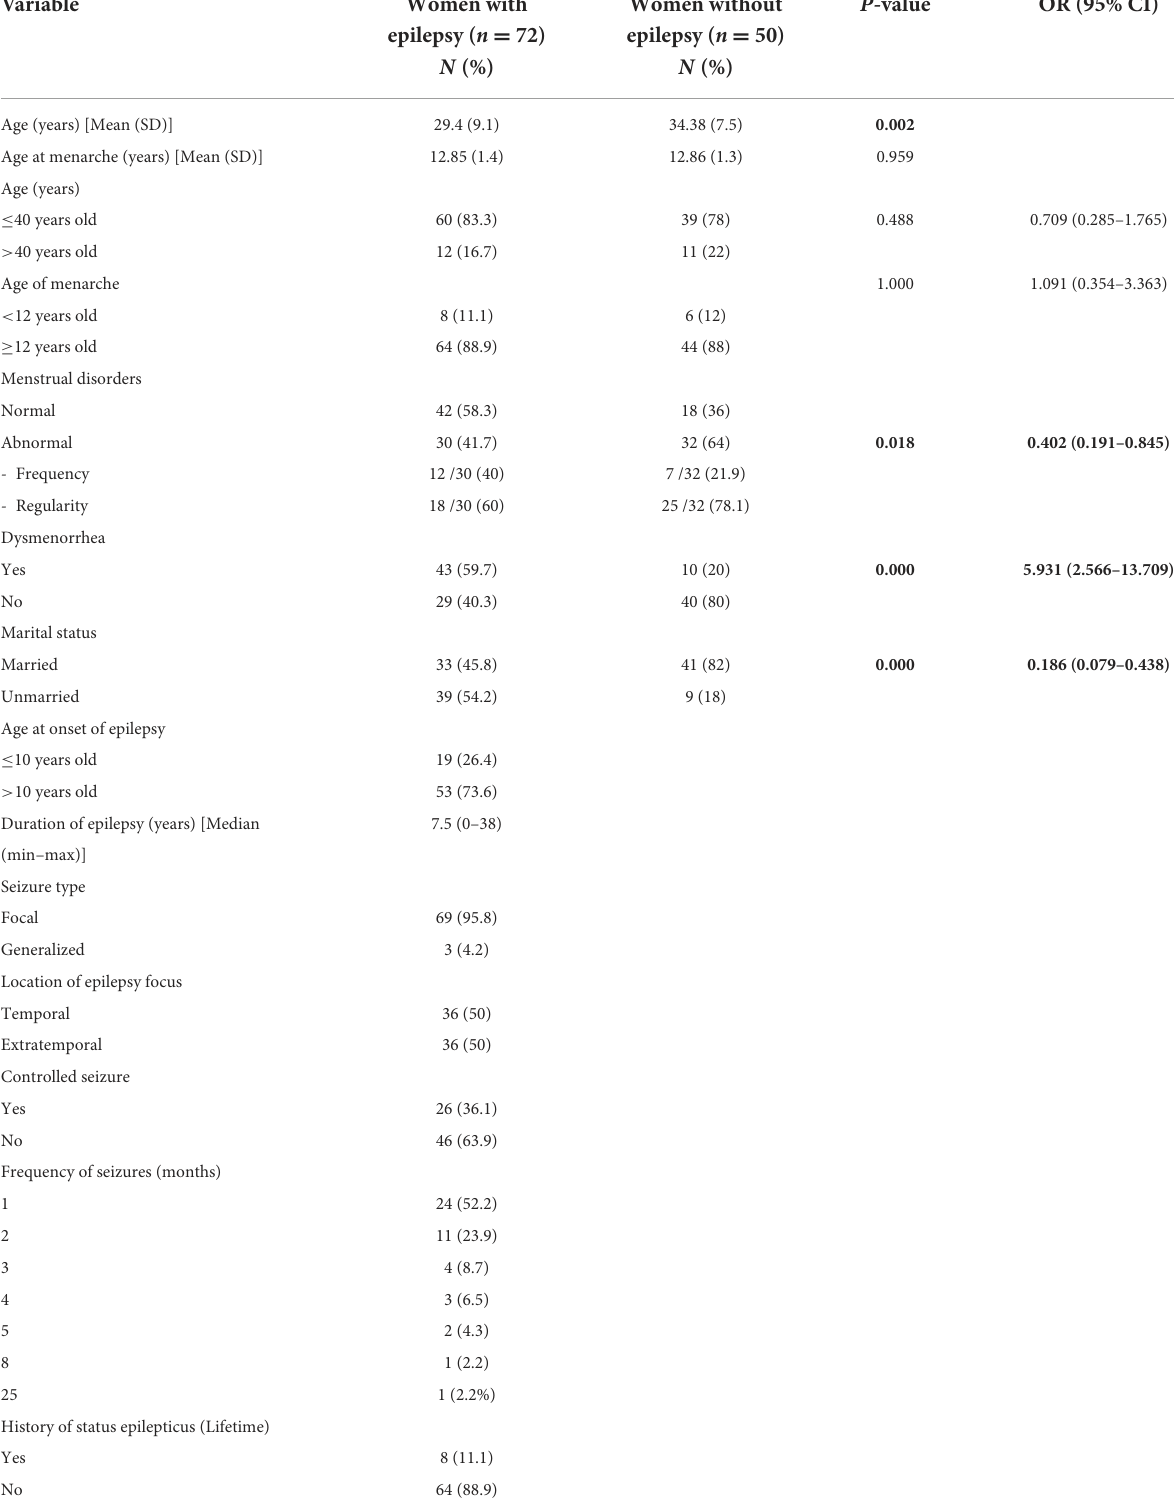
TABLE 1 Demographic characteristics of women with epilepsy and women without